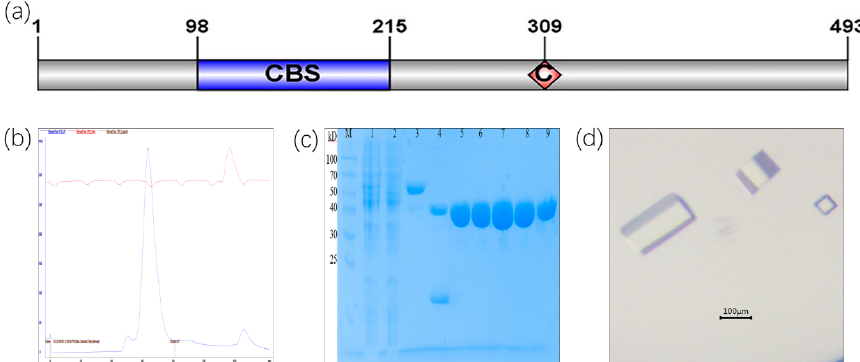
Figure 1. Size exclusion chromatogram and crystal of purified C Las IMPDH Δ 98 ‐ 201. ( a ): Primary